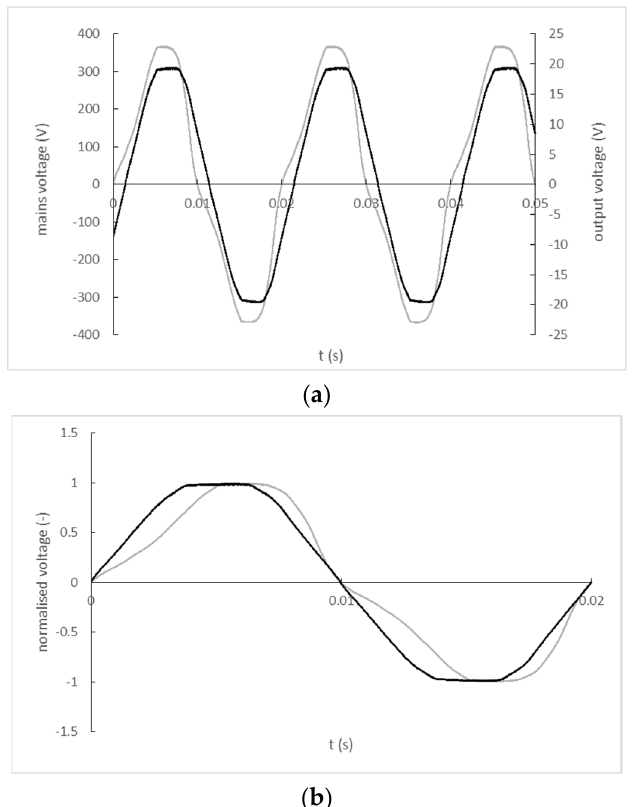
Figure 9. ( a ) The input and output signal record of the K-2803GCE-1FL (black line—mains; grey line—output); ( b ) Normalized and zero-crossing time shift-corrected input and output waveforms of K-2803GCE-1FL transformer (black line—mains; grey line—output).